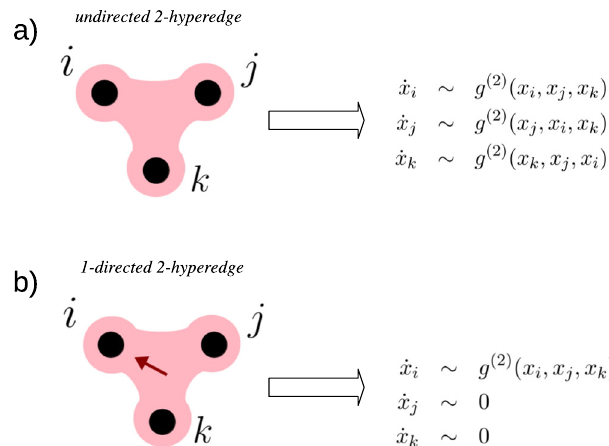
Fig. 4 From topology to dynamics: difference between the undirected and directed 1-hyperedge. Panel a : the derivative of the state variables associated to each node i , j , k receives a contribution from the higher-order interaction. Panel b : only the derivative of x i receives a contribution from the source nodes j and k , while the derivatives of the state variable of the source nodes, x j and x k , do